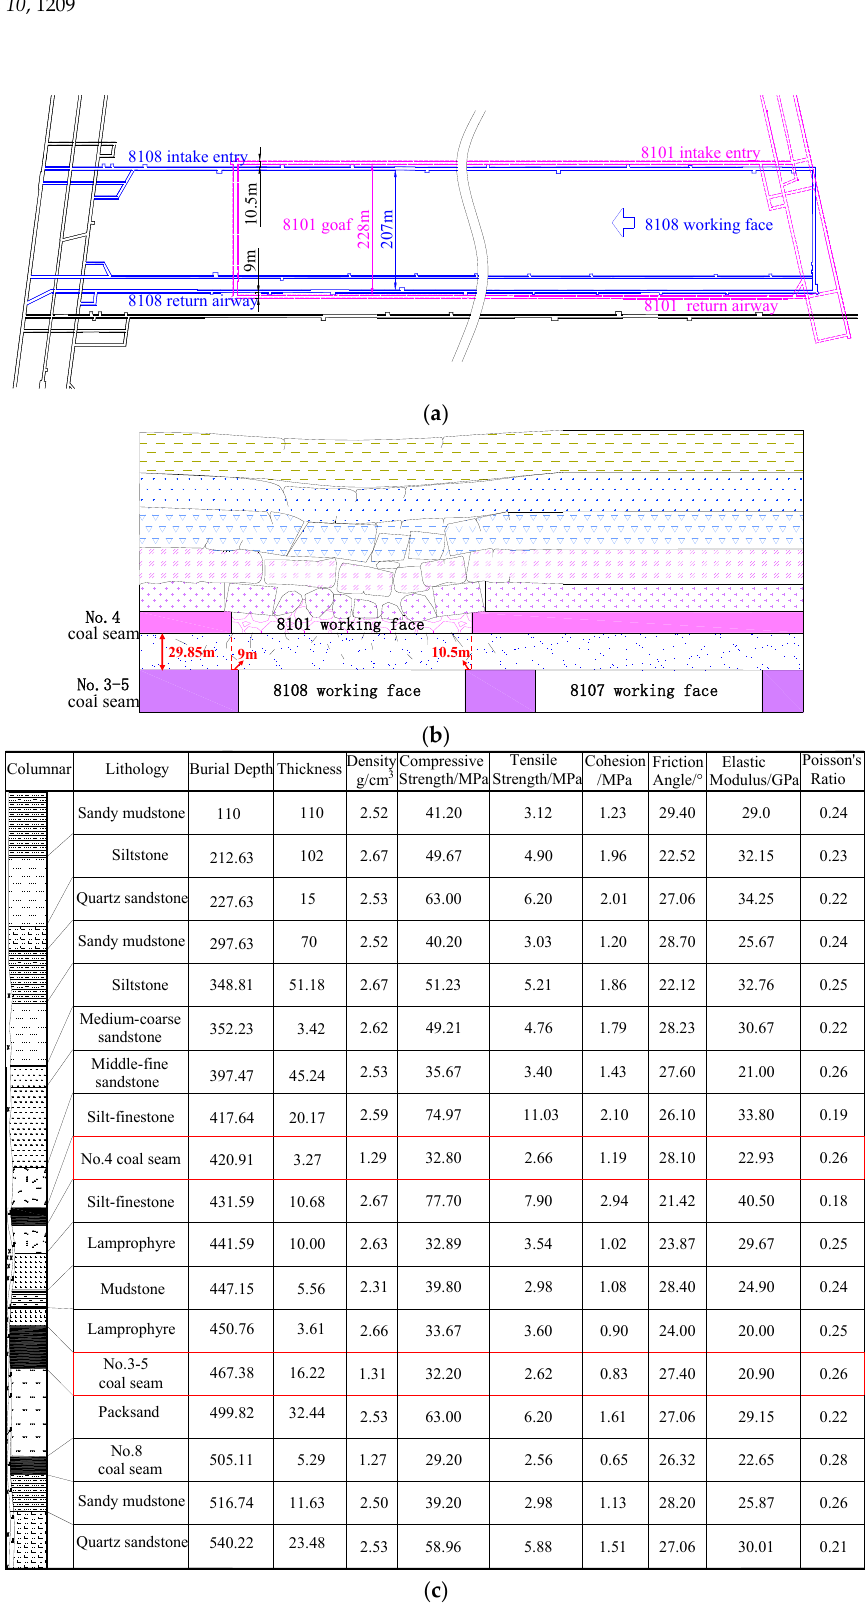
Figure 1. Location plans of 8108 and 8101 working faces and lithology of borehole; ( a ) plan view; ( b ) vertical section; ( c ) lithology of borehole.